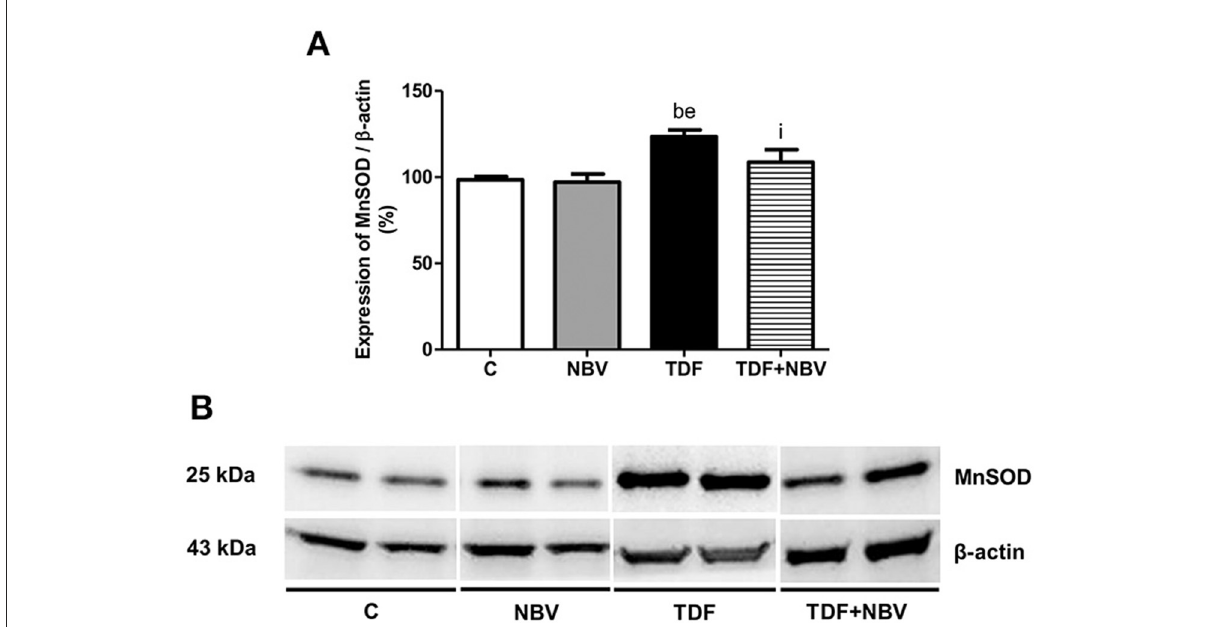
FIGURE7 Semiquantitative immunoblotting for MnSOD expression in rat kidney tissue. (A) MnSOD densitometric analysis of samples from C ( n = 7), NBV ( n = 7), TDF ( n = 8) and TDF + NBV ( n = 8) rats. (B) Representative immunoblots which reacted with anti-MnSOD revealing a band of 25kDa. Values are means ± SEM. b p < 0.01 vs. C; e p < 0.01 vs. NBV; i p < 0.05 vs. TDF. C, control; NBV, Nebivolol; TDF, Tenofovir.